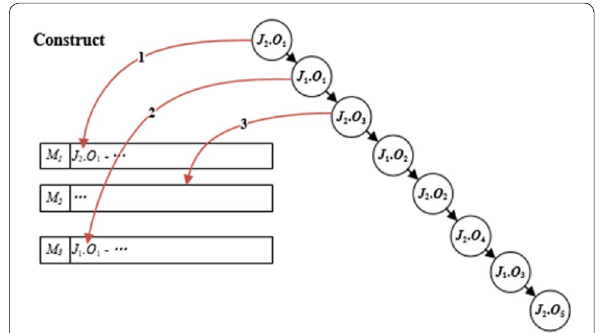
Figure 2 Construct phase–machine